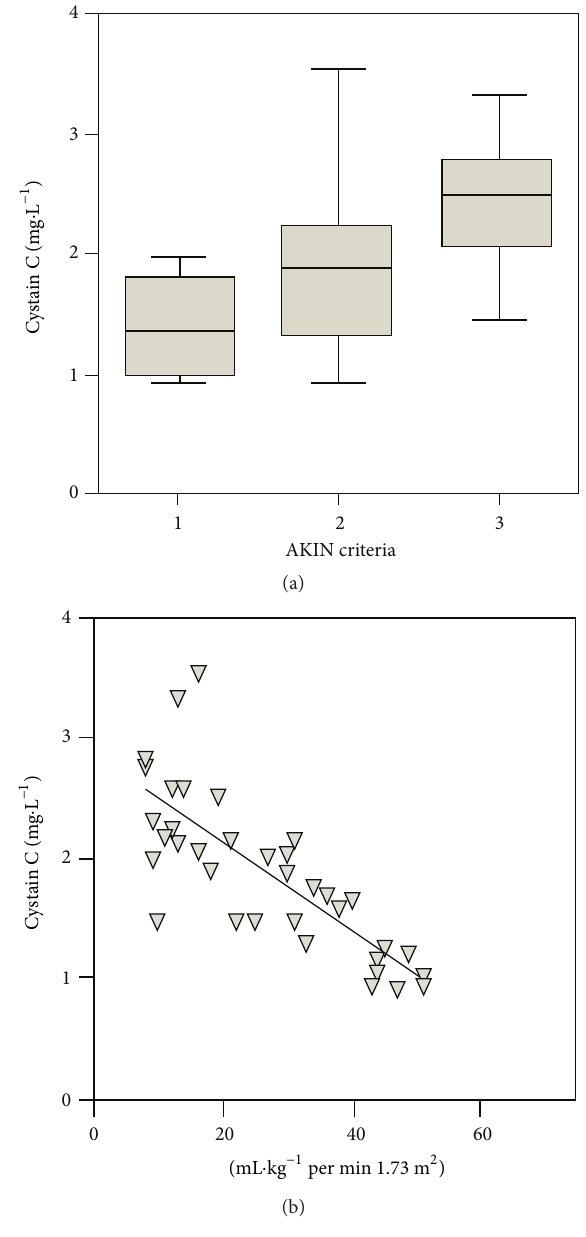
Figure 3: Wide range of serum cystatin C across the corresponding AKIN criteria and the correlation between 4 CrCl and cystatin C ( 𝑟 2 = 0.63 ; 𝑃 < 0.0001